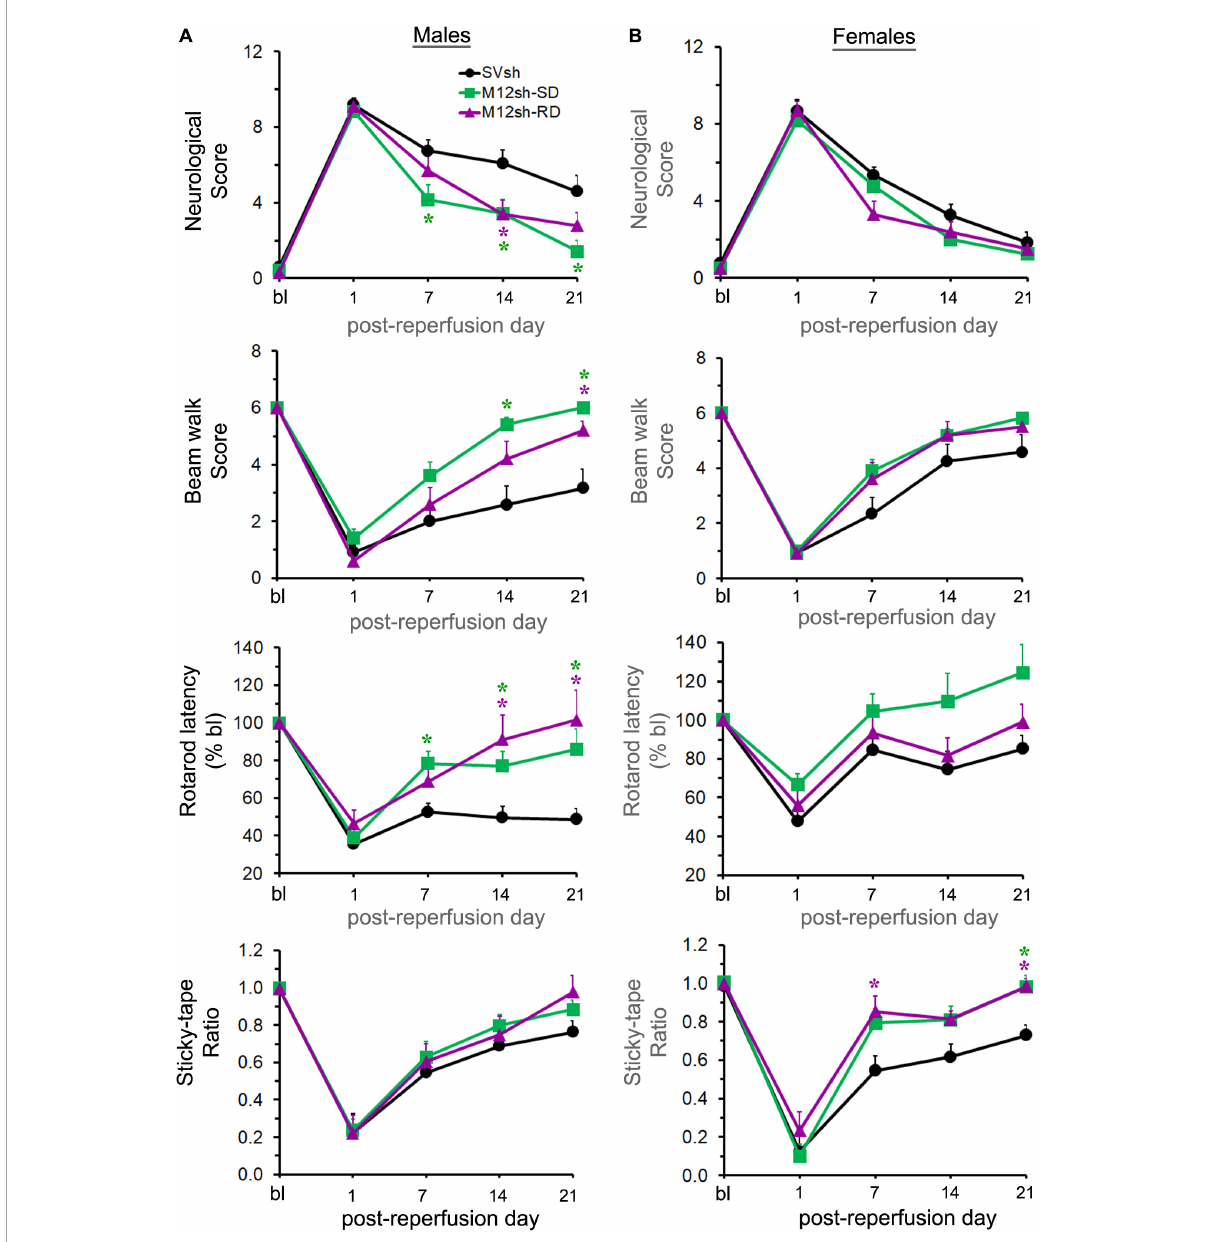
FIGURE5 Effect of acute vs. chronic suppression of MMP-12 on long-term neurological recovery after an ischemic stroke. Following 2-h focal cerebral ischemia, male (A) and female (B) rats subjected to treatments with either single-dose (SD) SVsh/M12sh (immediately after reperfusion) or repeated-dose (RD) M12sh (immediately after reperfusion and on post-reperfusion days 7 and 14) were evaluated for assessment of neurological and functional tests at baseline (bl) and at regular intervals (days 1, 7, 14, and 21). Post-ischemic neurological and functional deficits were assessed by the mNSS assessment, the beam walk, the accelerating Rotarod performance, and the modified adhesive removal tests. n = 8–12 males and 10–12 females (SVsh group), 10–12 males and 9–12 females (M12sh-SD group), and 9–10 males and 10 females (M12sh-RD group) for the different tests. Statistical analysis: Two-way repeated-measures ANOVA followed by Tukey’s multiple comparisons tests. * p < 0.05 vs. SVsh (respective post-reperfusion